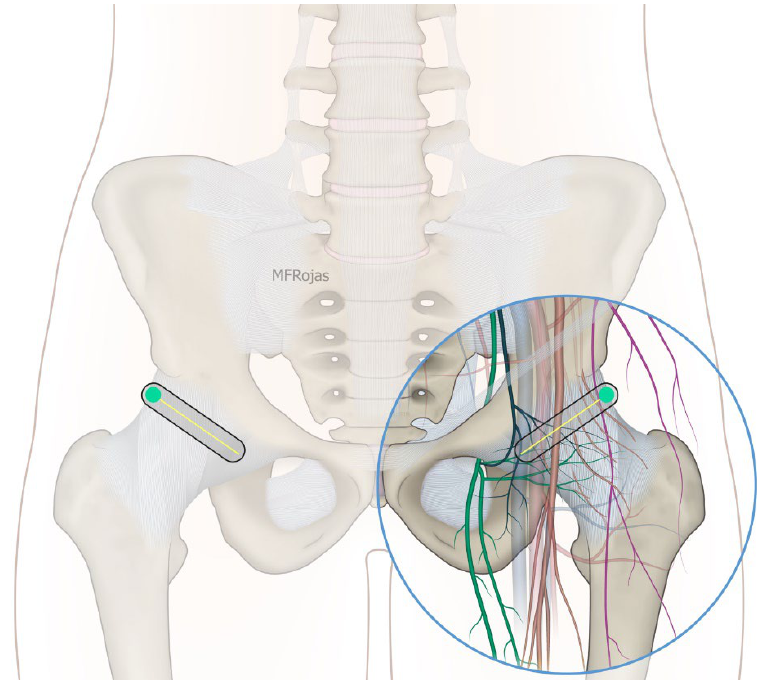
Figure 4. A schematic diagram to show that the probe slides caudally from the IPE-AIIS plane until the pubic bone drops out and the hypoechoic capsule is revealed. Reproduced with permission from Dr Maria Fernanda Rojas Gomez (Bucaramanga, CO). Green dot: transducer mark.